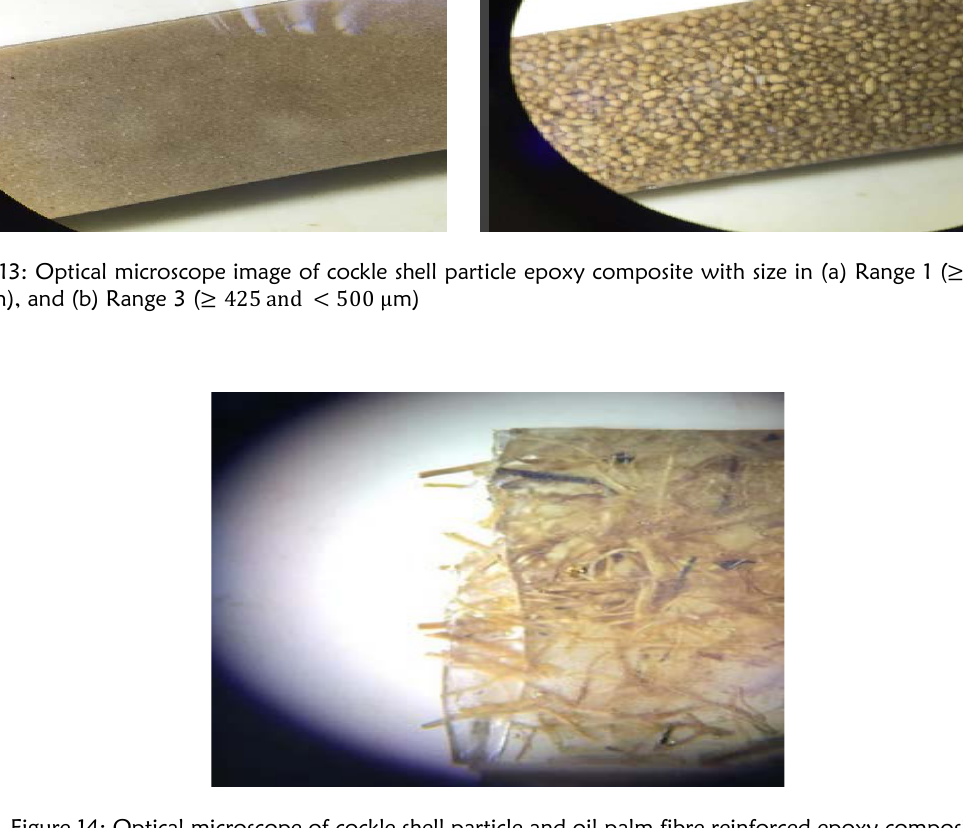
Figure 14: Optical microscope of cockle shell particle and oil palm fibre reinforced epoxy